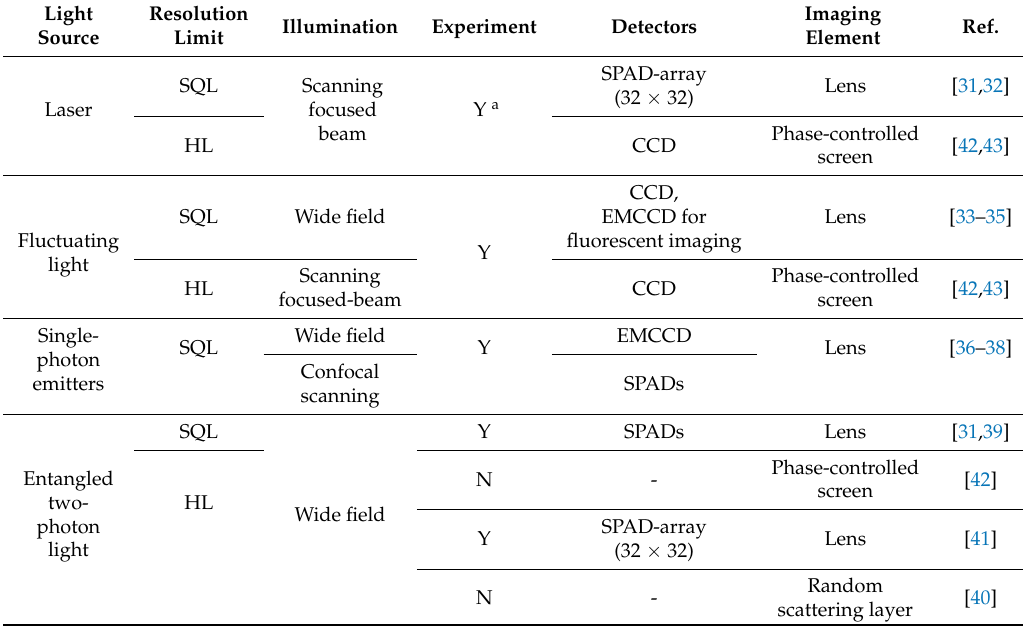
Table 1. A summary of different super-resolution schemes based on optical high-order